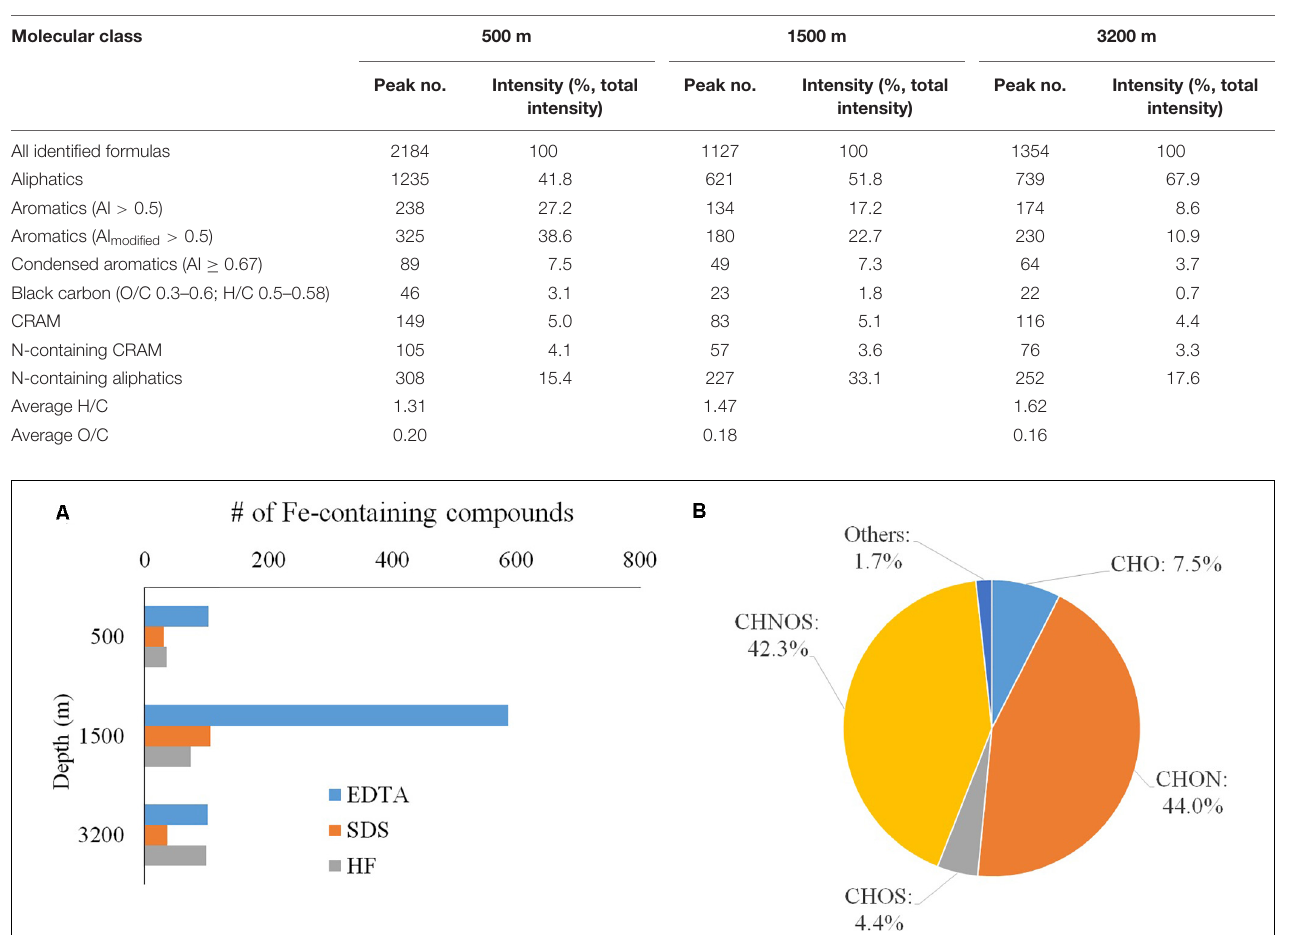
FIGURE 5 | (A) Depth distribution; (B) elemental grouping of Fe-carrying